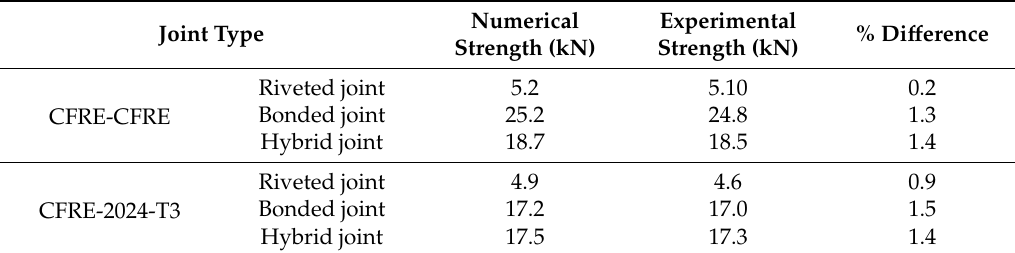
Table 8. Strength of the studied joints as obtained from numerical analysis and experiments, and error between numerical and experimental